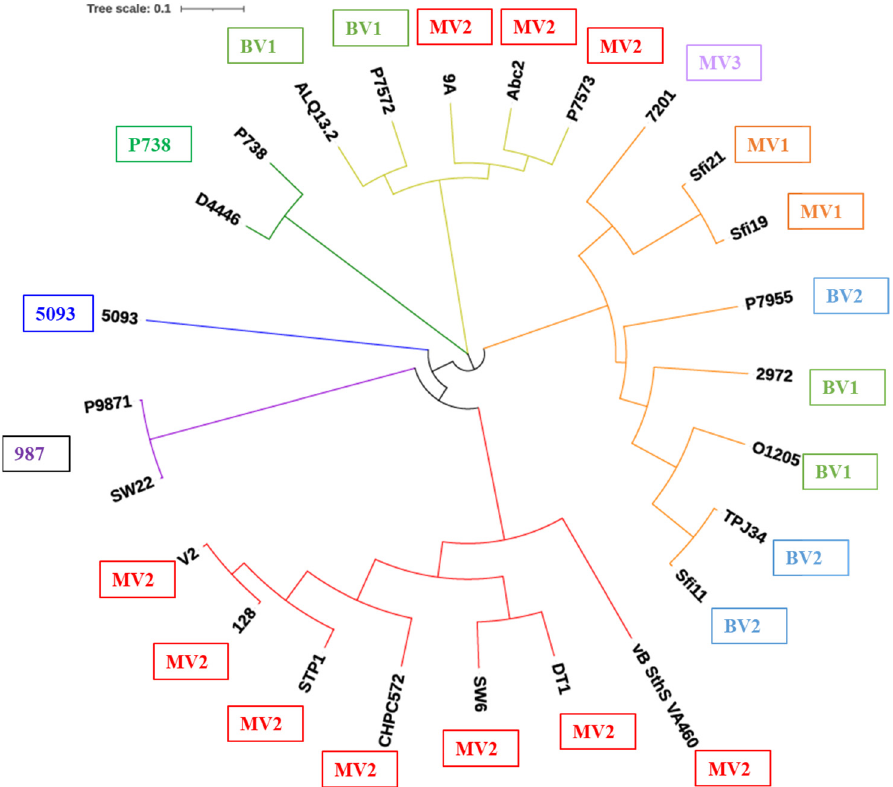
Figure 6. Phylogenetic tree based on the amino acid sequence alignment of carbohydrate binding domain sequences of the RBP or Bpp of 25 dairy streptococcal phages. The colored clades are based on the phage groups to which the phages belong, i.e., P738, dark green; Brussowvirus members, lime green; Moineauvirus members, orange or red; 987, purple; 5093, deep blue. The text boxes outside the tree indicate the groupings of morphogenesis modules identified in Figure 4, Table 1. There is a distribution of binding domain sequence types among Brussowvirus and Moineauvirus members, suggesting that the binding domains have been acquired separately to the overall morphogenesis modules in certain phages.